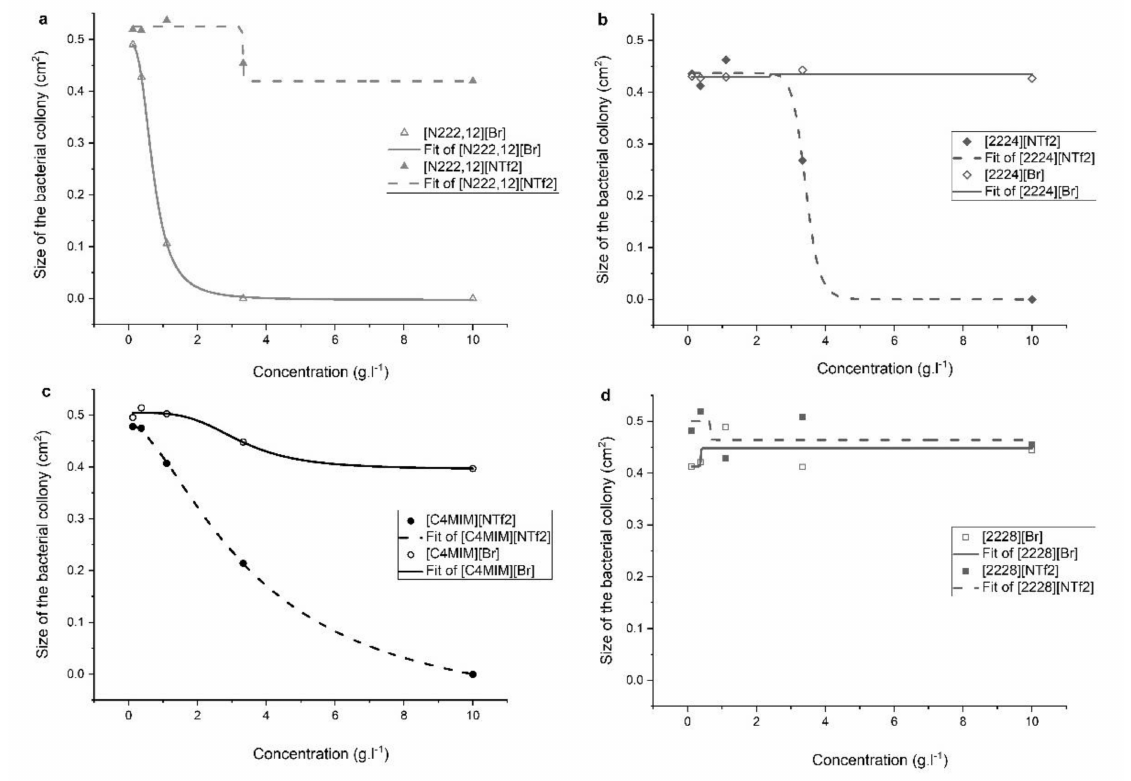
Figure 2. Concentration dependency of the inhibitory e ff ect of ILs on the growth of Bacillus subtilis . Ammonium ( a , b , d ) and imidazolium ( c ) ionic liquids and their precursors were tested.